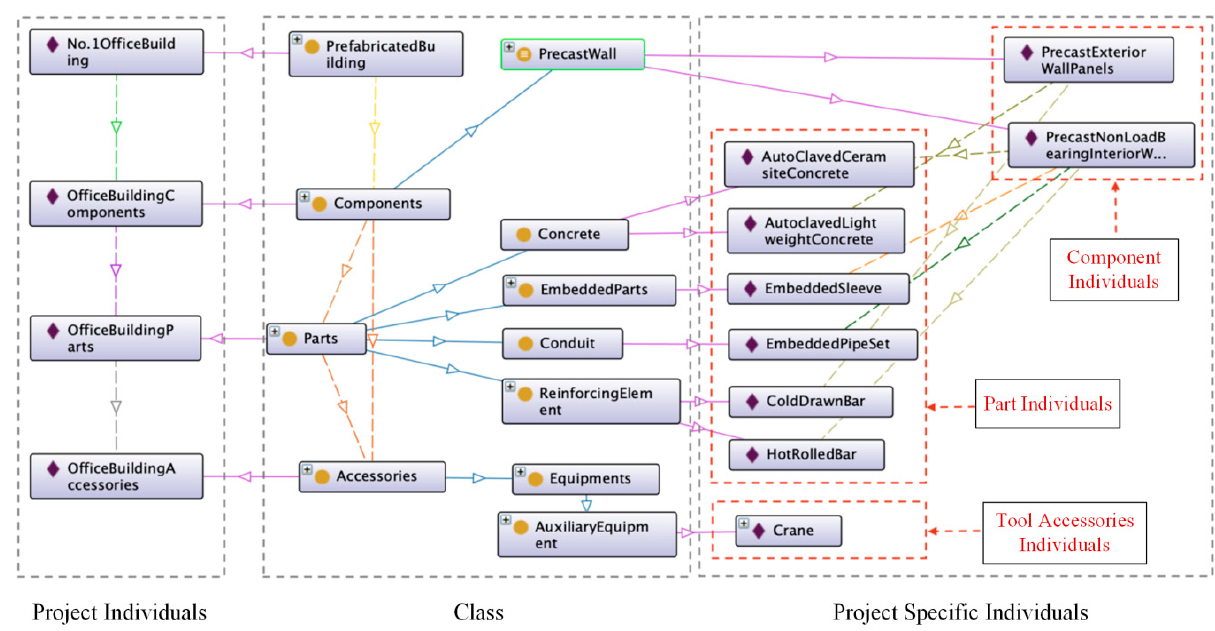
Figure 24. Knowledge graph of BIM assembly model.